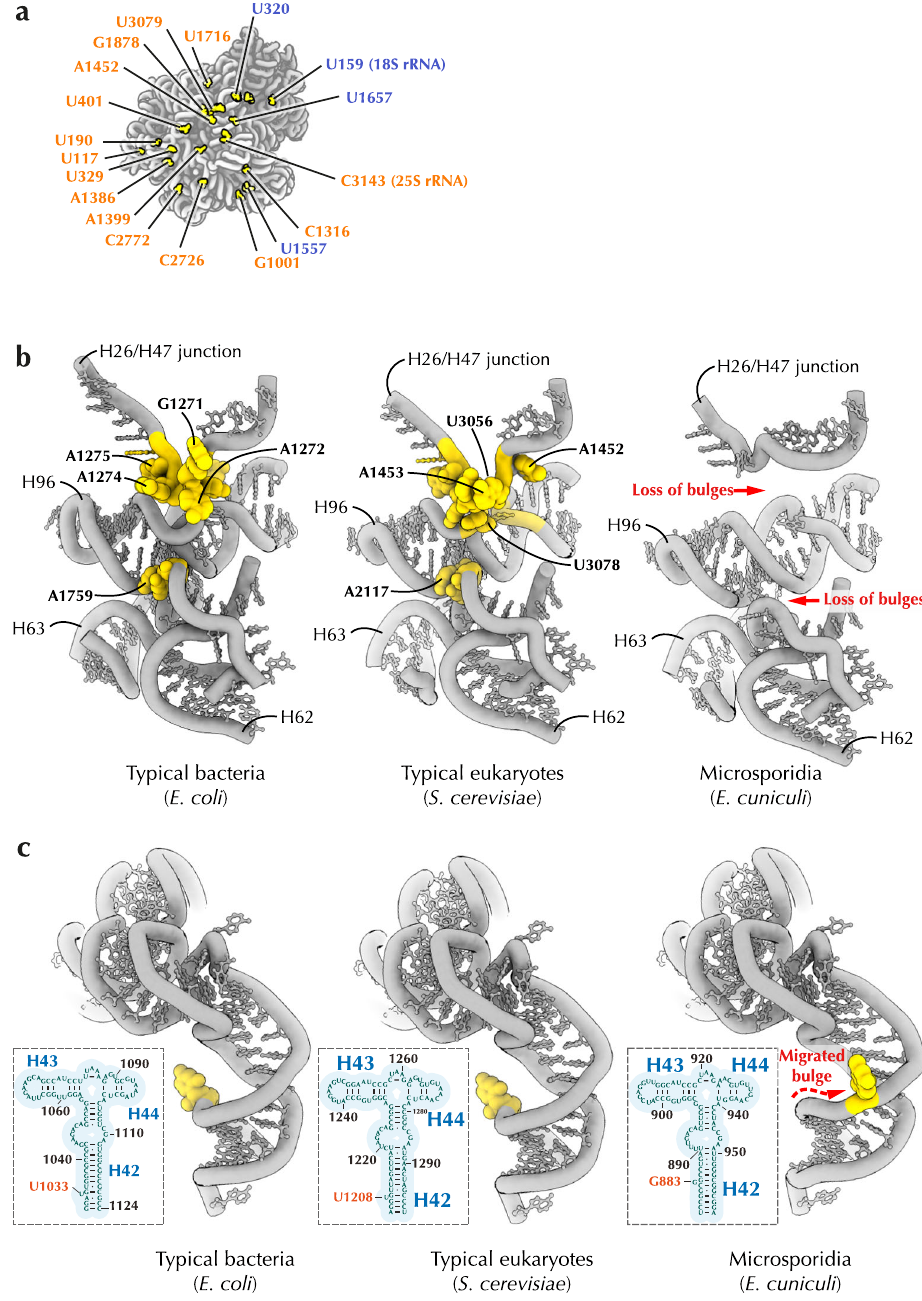
Fig. 4 Microsporidian rRNA is stripped of highly conserved bulges. a rRNA bulges ( S. cerevisiae numbering) that are missing in the structure of E. cuniculi ribosomes but present in most other eukaryotes b Comparison of the ribosome interior of E. coli , S. cerevisiae , H. sapiens and E. cuniculi illustrates that microsporidian parasites lack many ancient, highly conserved rRNA bulges. These bulges stabilize ribosome structure, therefore their absence in microsporidia suggests decreased stability of rRNA folding in microsporidian parasites. c Comparison with the P-stalk (L7/L12-stalk in bacteria) illustrates that the loss of rRNA bulges can occasionally co-occur with the emergence of new bulges in the vicinity of the lost ones. The helix H42 in 23 S/28 S rRNA possesses an ancient bulge (U1206 in S. cerevisiae ), which is estimated to be at least 3.5 billion years old due to its conservation across the three domains of life. In microsporidia, this bulge has been eliminated; however, a new bulge (A1306 in E. cuniculi ) has evolved in the vicinity of the lost